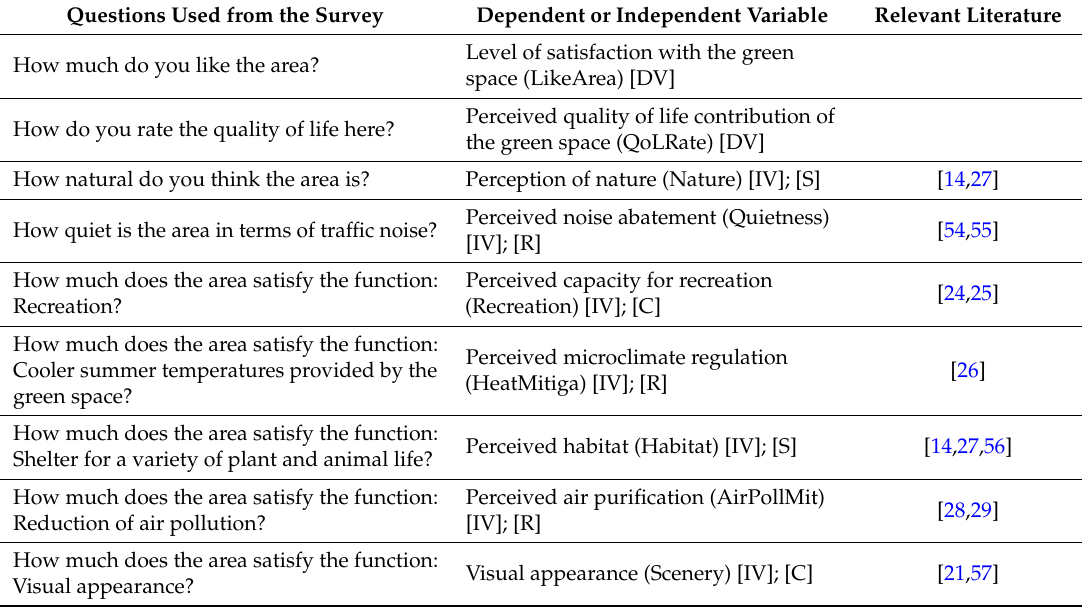
Table 1. Dependent and independent